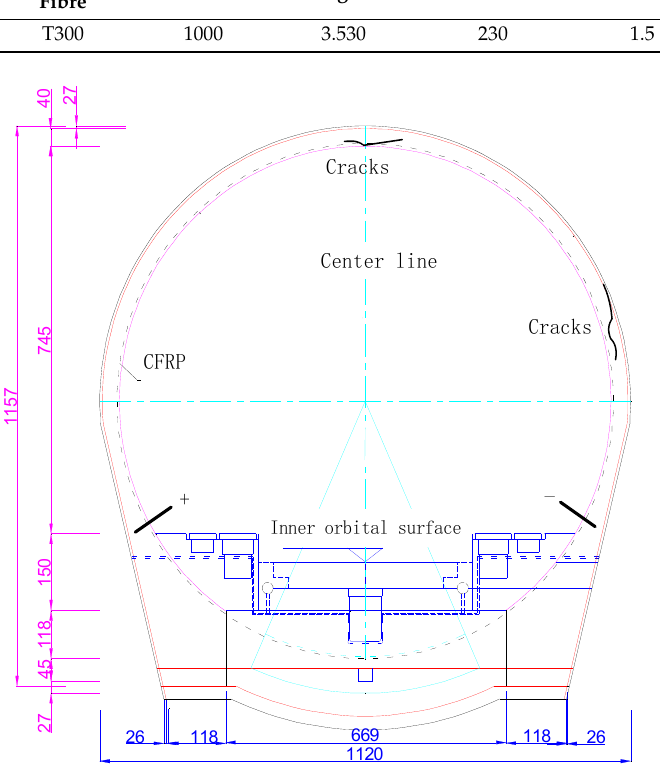
Figure 13. Crack warning method for CFRP reinforced tunnel lining.